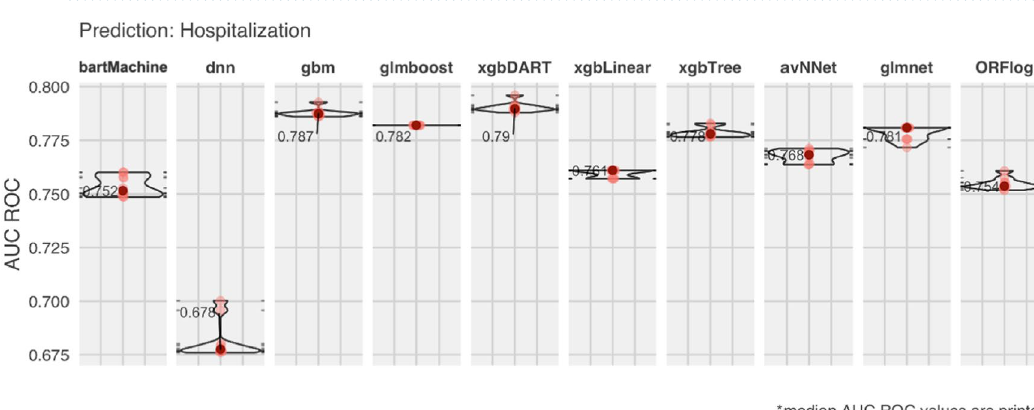
Figure 1. Probability of the sequential scenarios for outcomes after COVID-19 infection.